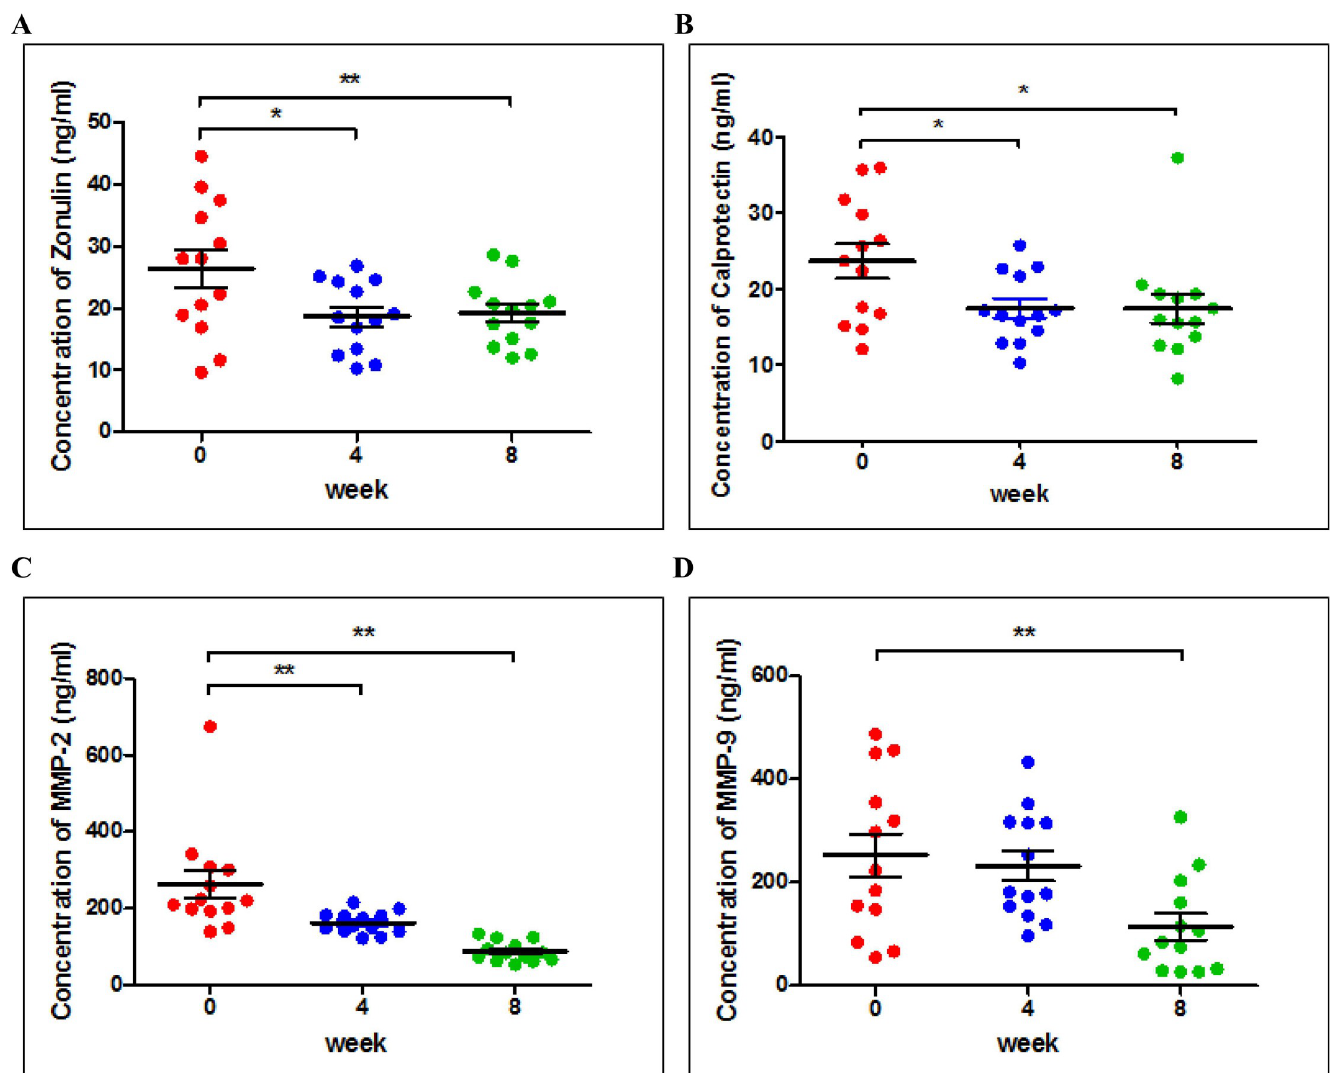
Fig 4. Comparison of biomarker concentrations in plasma. Changes in Zonulin(A), Calprotectin(B), MMP-2(C) and MMP-9(D) levels in plasma before and after HY7714 consumption over 8 wk. Data are analyzed using the Wilcoxon signed-rank test. Results are expressed as Mean ± SEM. Asterisks ( � and �� ) indicate a significant difference (p < 0.05 and p < 0.01, respectively) compared to the control. Each dot represents an individual. PPS: per protocol